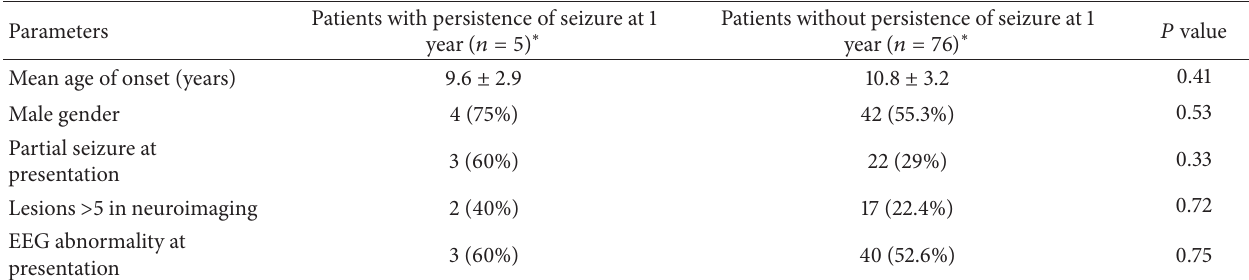
Table 6: Comparison between patients with and without persistence of seizure at 1